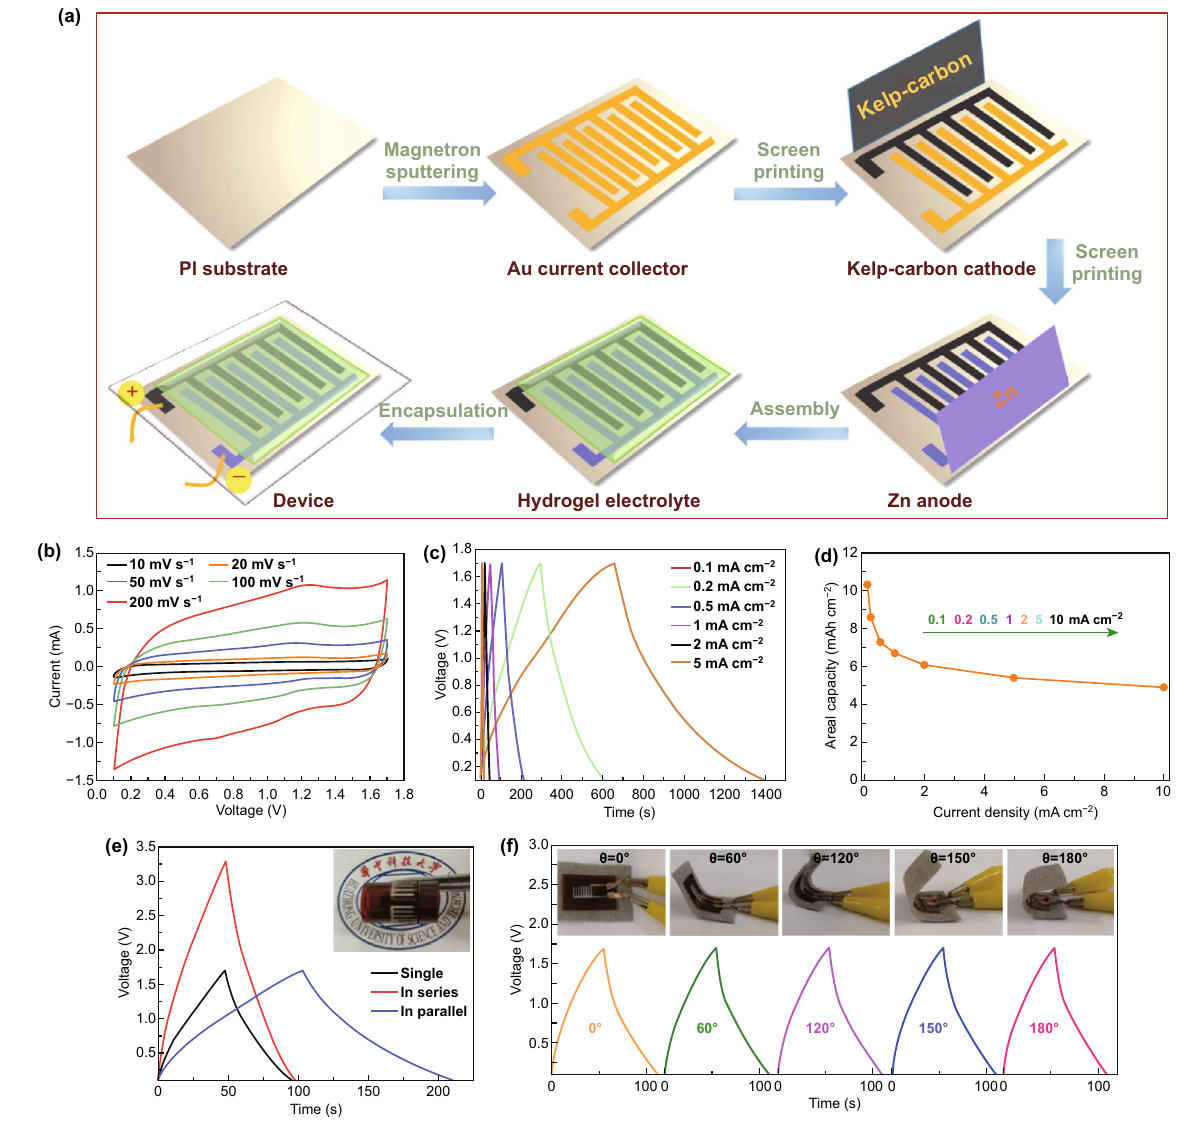
Fig. 5 a Fabrication procedure for the flexible quasi-solid-state micro-ZHCs. b CV curves of the micro-ZHCs at different scan rates. c GCD curves at different current densities. d Areal capacity and rate capability. e GCD curves at 1 mA cm −2 of a single cell, and two cells connected in series or parallel. The inset shows two cells connected in series and good flexibility of the device. f GCD curves at 1 mA cm −2 of the micro- ZHCs under different bending angles from 0° to